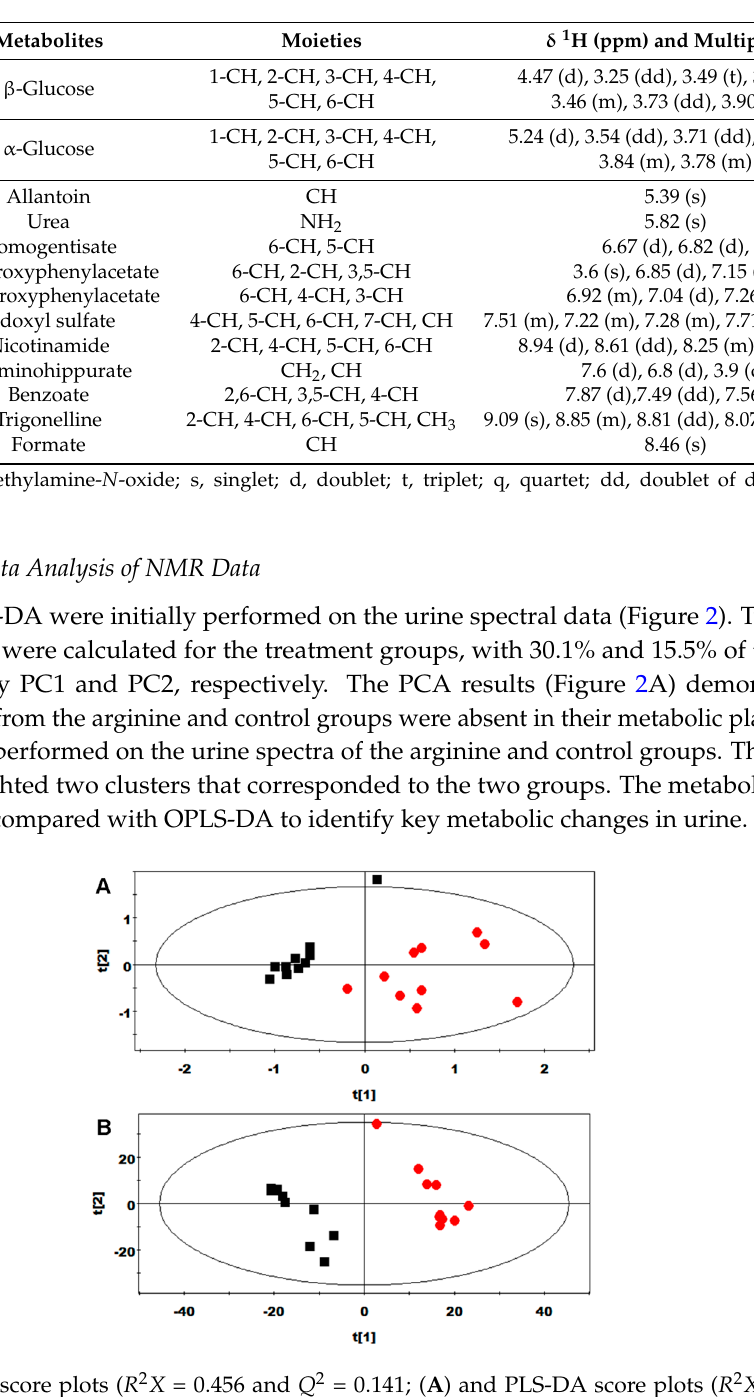
Figure 2. PCA score plots ( R 2 X = 0.456 and Q 2 = 0.141; ( A ) and PLS-DA score plots ( R 2 X = 0.312, R 2 Y = 0.978, and Q 2 = 0.873; ( B ) obtained through 1 H-NMR spectra of 24 h urine samples from the arginine (red circles) and control (black squares) groups.